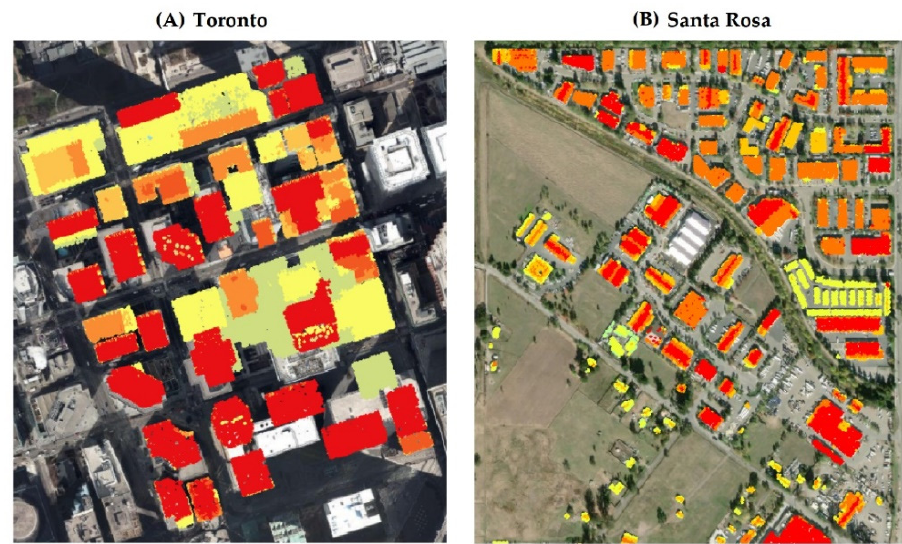
Figure 13. The point cloud (colorized by height) of test dataset and overlapped airborne imagery ( A ) Toronto. ( B ) Santa Rosa. Table 1. Basic information of test